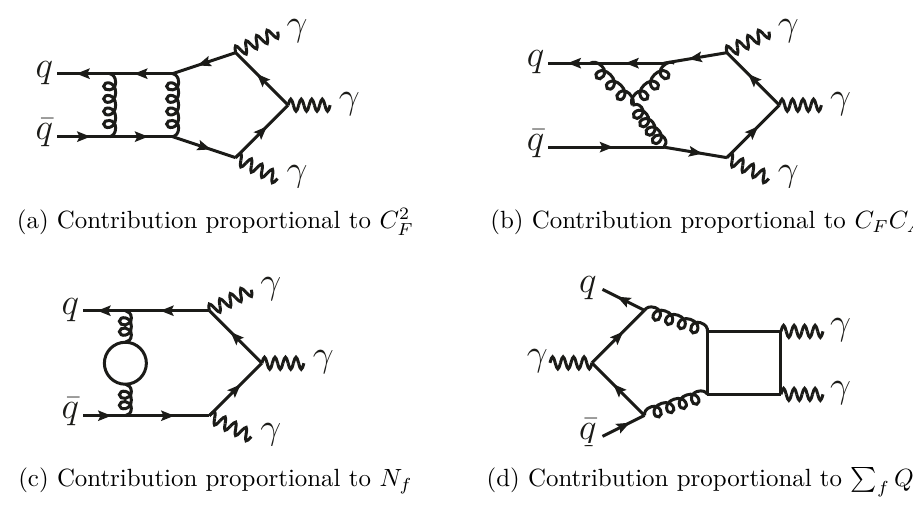
Figure 1. Representative diagrams for each of the contributions in eq. (2.13). Photons ( γ ) are denoted by wavy lines, gluon by curly lines, and quarks by straight